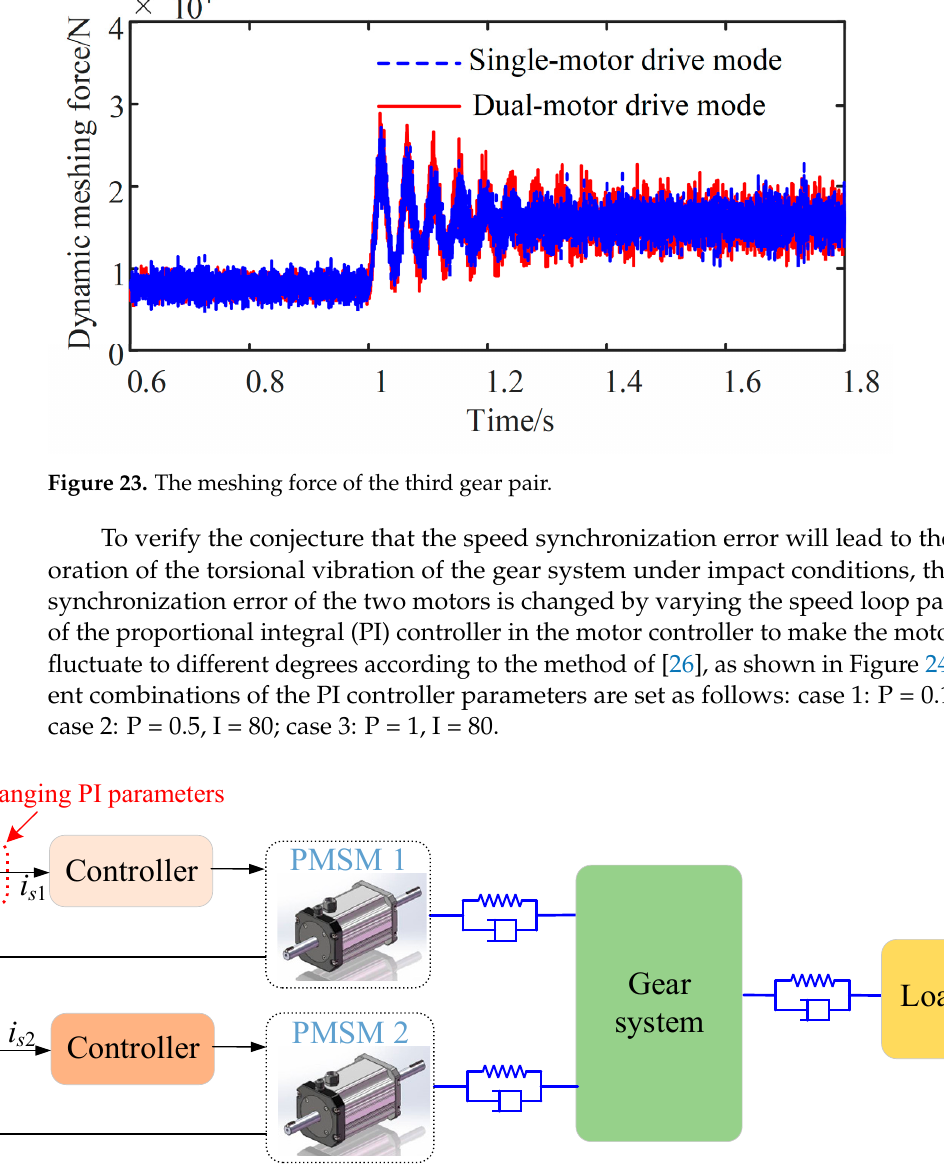
17 of 23 Figure 21. The meshing force of the first gear pair with different connection stiffness. From Figures 20 and 22 it can be seen that after the system is subjected to an impact load, there is a sudden change in the amplitude of the frequency related to the gear mesh- ing information in the motor stator current frequency, and the amplitude of the different torsional vibrations of the gear system can be reflected in the current signal. It shows that the motor stator current has an obvious feedback effect on the vibration of the gear system. ( a ) ( b ) ( c ) Figure 22. Time-frequency domain of the stator current of motor 1 with different values of motor shaft stiffness: ( a ) case 3; ( b ) case 2; ( c ) case 1. 4.2. Dual-Motor Drive Mode To investigate the dynamic response of the electromechanical coupling of the DEDS dual-motor drive mode under impact conditions, the speed of the two motors and the load of the system are shown in Figure 15. The third gear pair is fully loaded in both single- and dual-motor drive modes, so it is necessary to compare the dynamic response of the third-stage gear pair in both modes with the other conditions held constant. As can be seen in Figure 23, the meshing force of